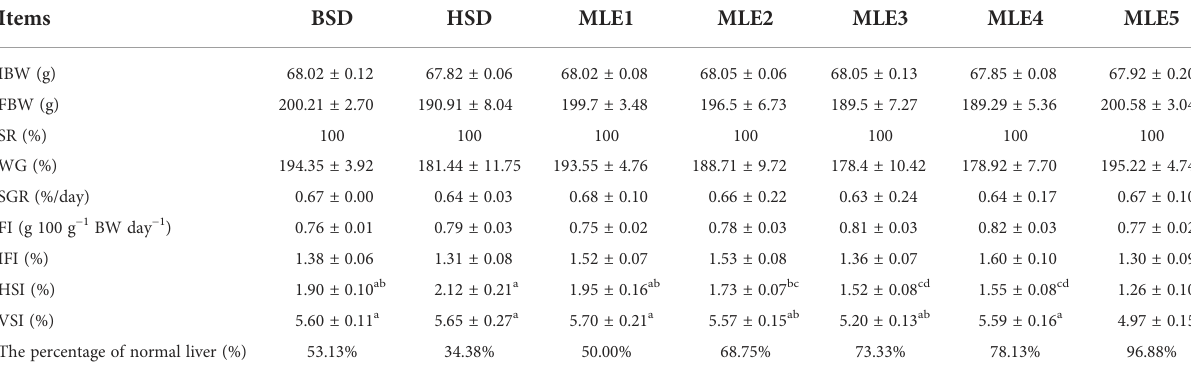
TABLE 2 Effects of mulberry leaf extract on growth performance and feed utilization of Micropterus salmoides fed high-starch diet diets.